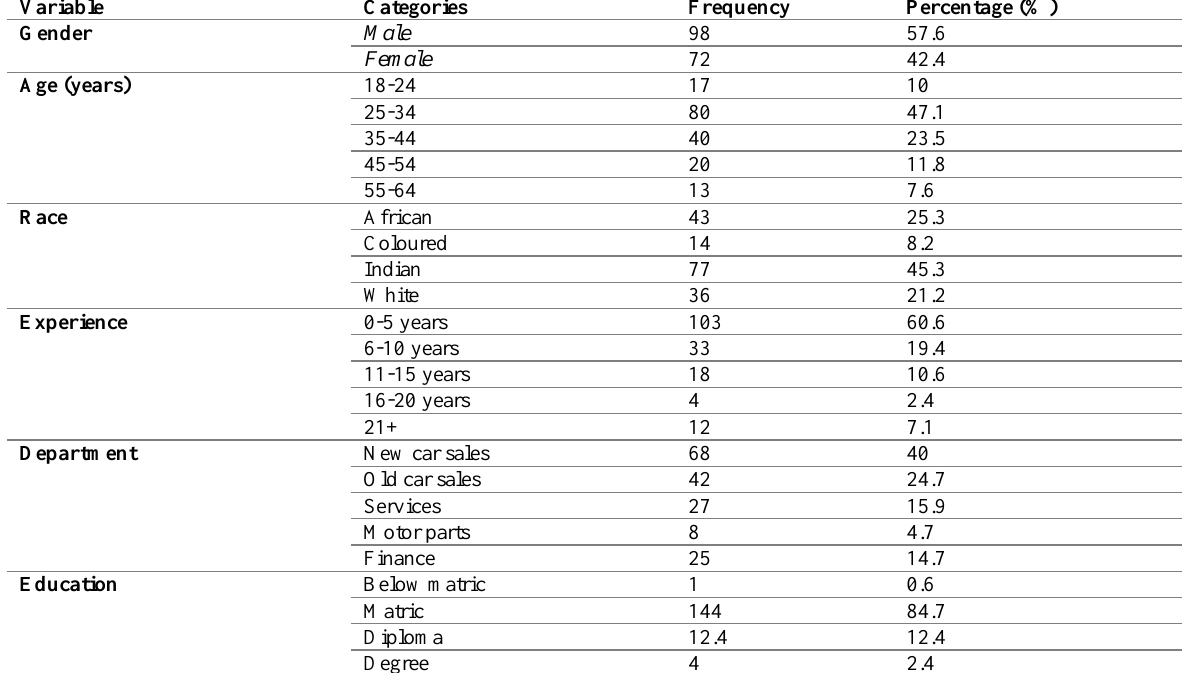
Table 1: Respondents socio-demographic